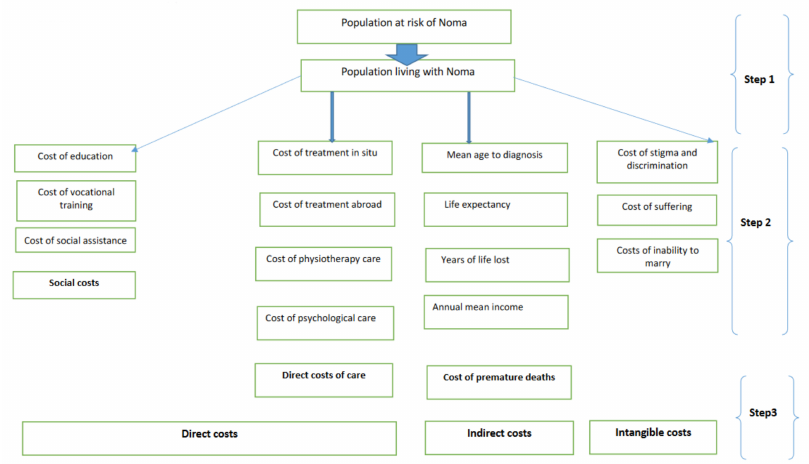
Figure 1. Cost estimation model. Economic and social costs of